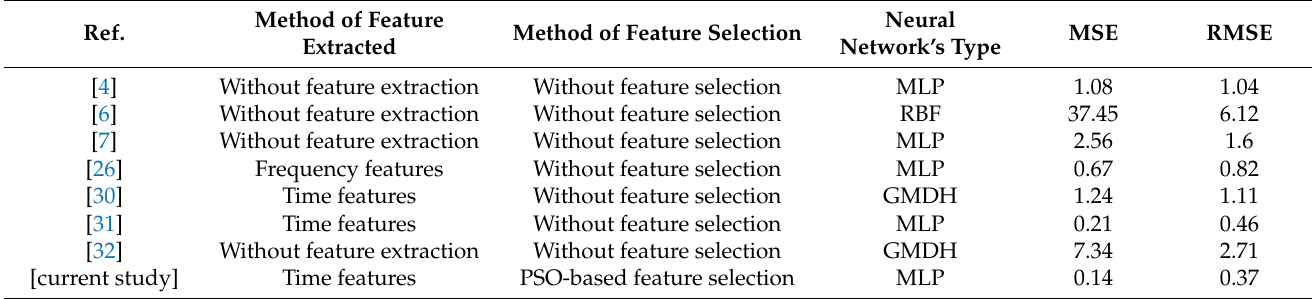
Table 3. Examination of the presented detection system’s accuracy in light of related